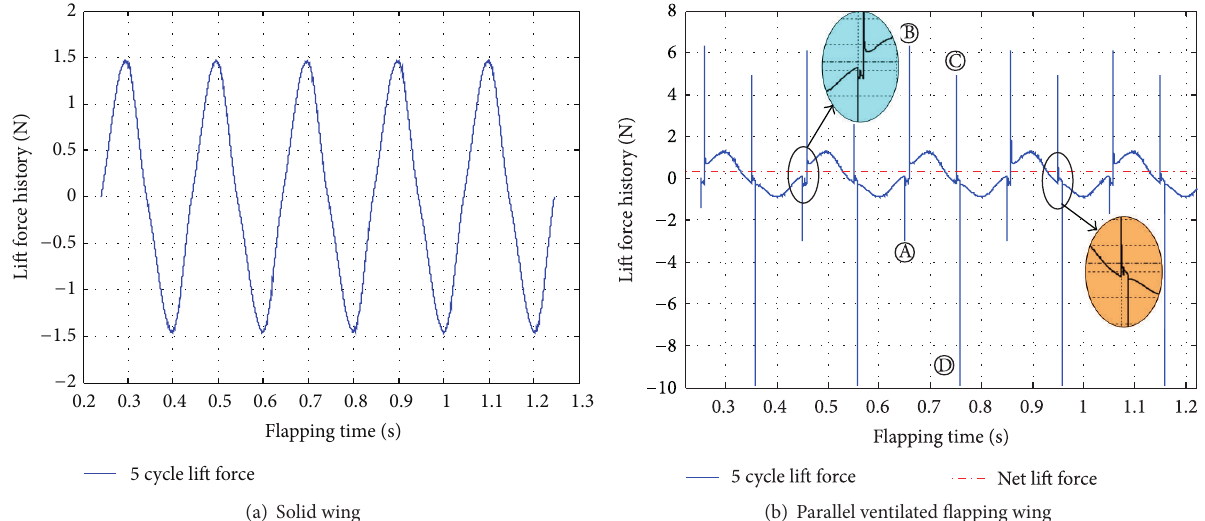
Figure 10: Lift force history during five flapping